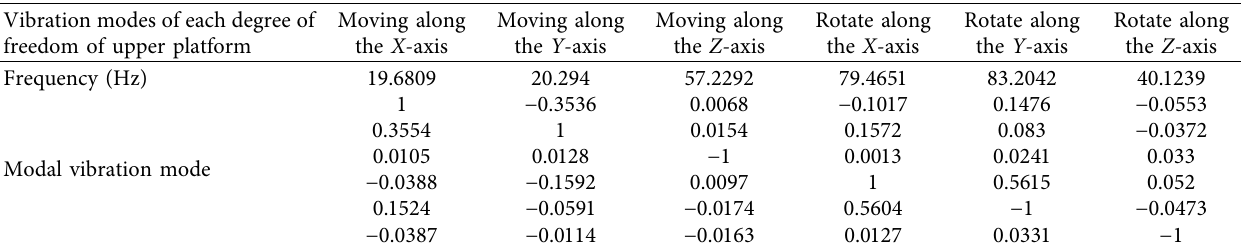
Table 5: Modal frequencies and corresponding modal shapes of the Stewart platform in Case (d). Vibration modes of each degree of freedom of upper platform